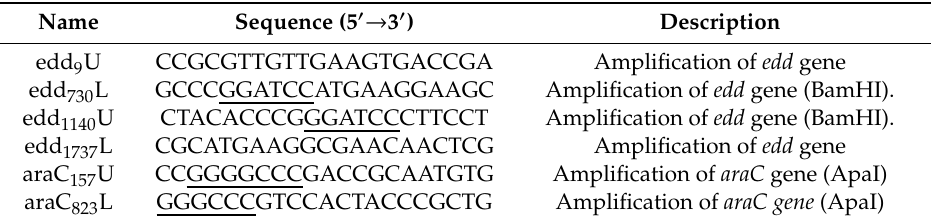
Table 1. Primers utilized in this